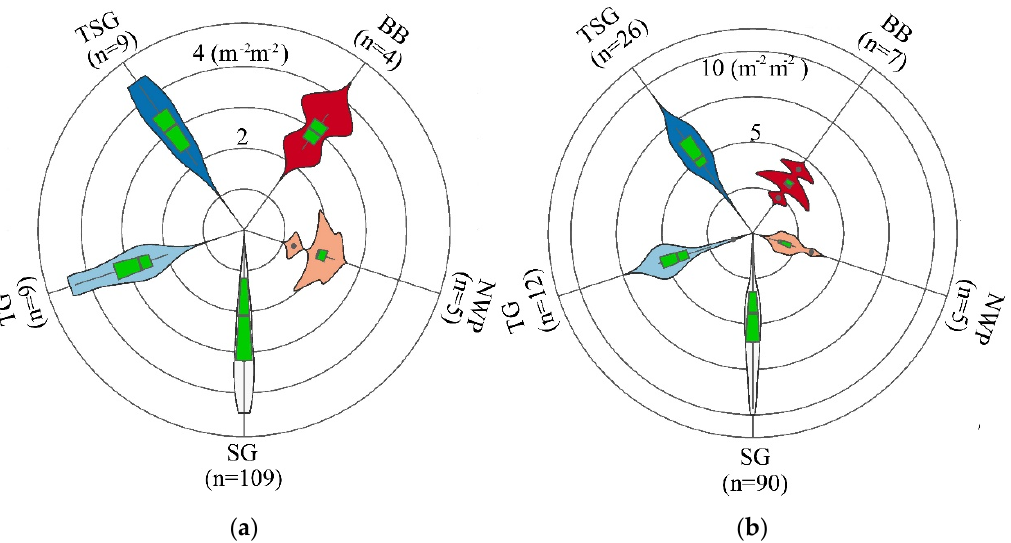
Figure 2. Distribution of field LAI of different forest landscape types in ( a ) Xingguo and ( b ) Gandong. TSG, SG, TG, NWP, and BB denote the types of forest landscape of tree-shrub-grass, shrub-grass, tree-grass, non-wood product forests, bamboo forests.